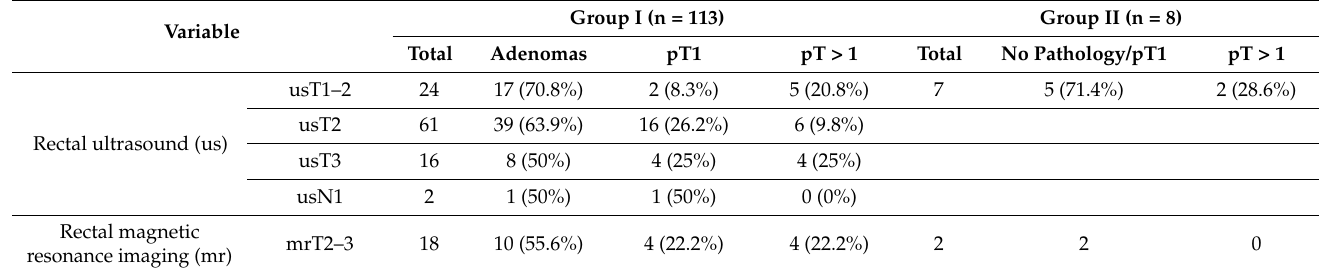
Table 2. Uncertain diagnosis of groups I and II based on ERUS or MR.